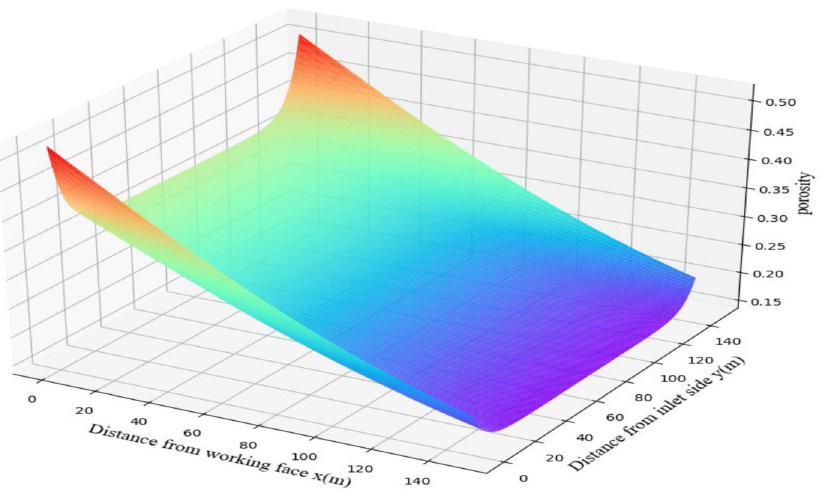
Fig 5. Porosity distribution in